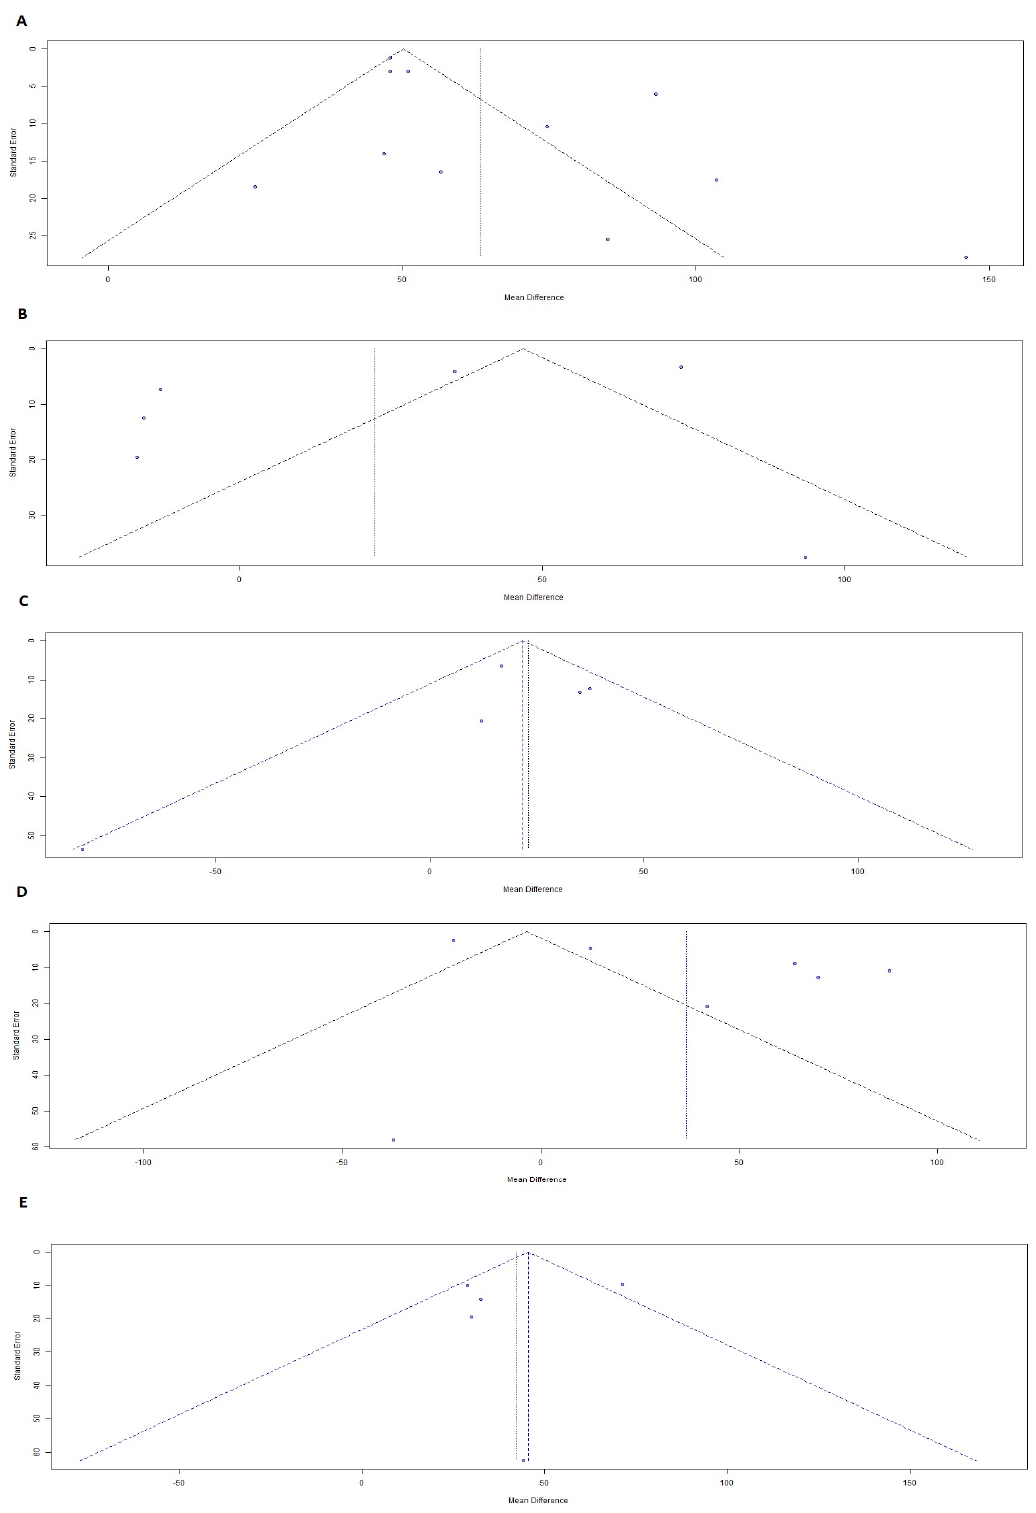
Figure 2. Funnel plots for YKL-40 CSF levels in AD versus NC ( A ), MCI versus NC ( B ), MCIAD versus MCI ( C ), AD versus MCI ( D ), and AD versus MCIAD ( E ) indicating no publication bias according to Egger’s linear regression test. The circles indicate the individual studies included in this analysis. The black dotted line indicated the combined standard error of the mean differences, while the blue dotted line indicated the 95% confidence intervals.